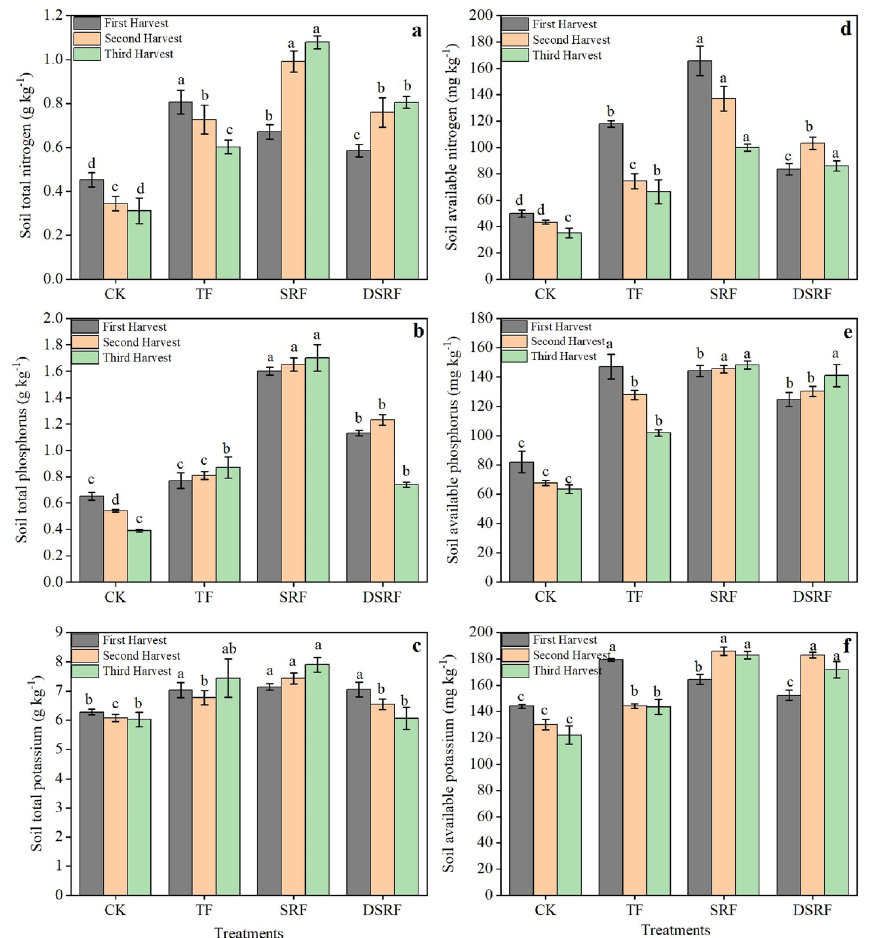
Figure 5. Soil total nitrogen ( a ), total phosphorus ( b ), total potassium ( c ), available nitrogen ( d ), available phosphorus ( e ), and available potassium ( f ) of wintering Chinese chives as affected by different fertilizer treatments. Lowercase letters indicate significant differences among different fertilization treatments ( p < 0.05). CK no fertilizer, TF traditional fertilization, SRF traditional fertilization with slow-release fertilizer, DSRF decreased fertilization with slow-release